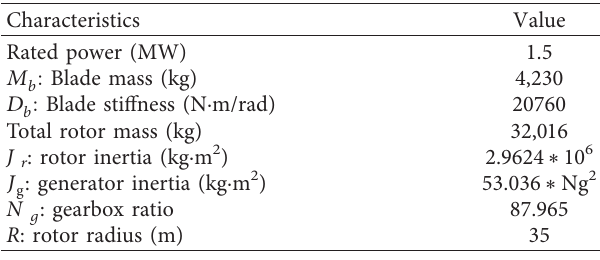
Table 1: Wind turbine parameters.